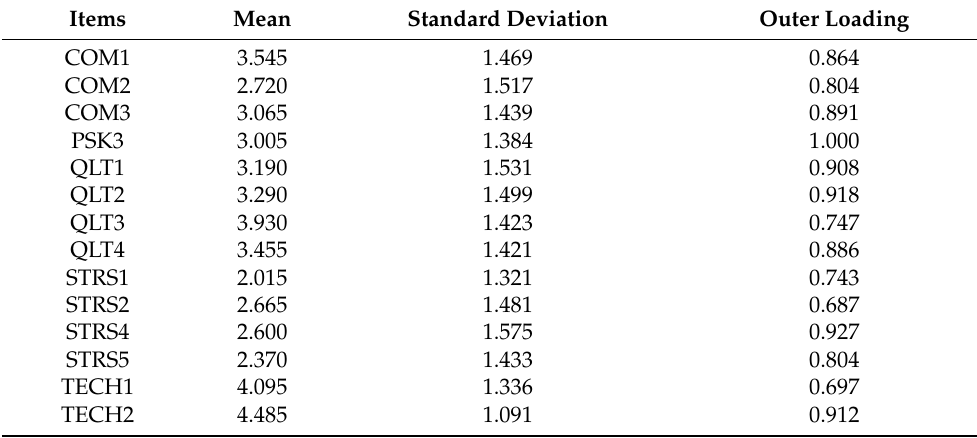
Table 3. The descriptive statistics of the items kept in the model.